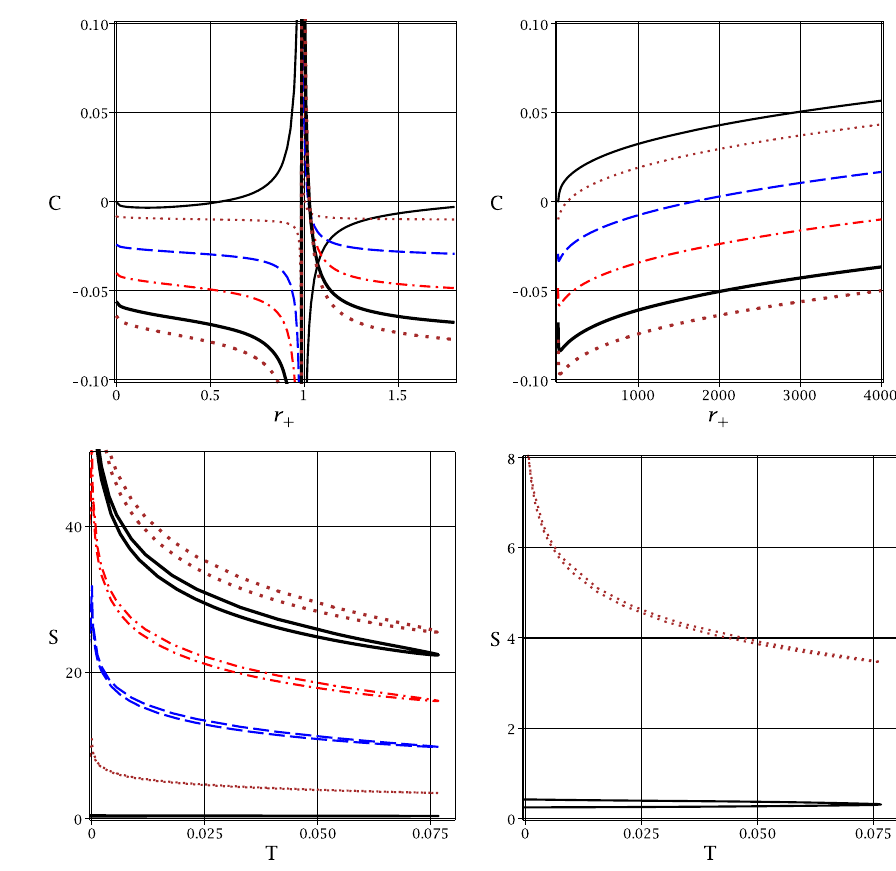
Fig. 5 C versus r + (up panels) and S versus T (lower panels) for k = 1, m = 5, (cid:16) = − 1, b = 1, q = 1, β = 1, f (ε) = g (ε) = 0 . 9, α = 2, ζ = 0 (continuous line), ζ = 1 (dotted line), ζ = 3 (dashed line), ζ = 5 (dashed-dotted line), ζ = 7 (bold continuous line) and ζ = 8 (bold dotted